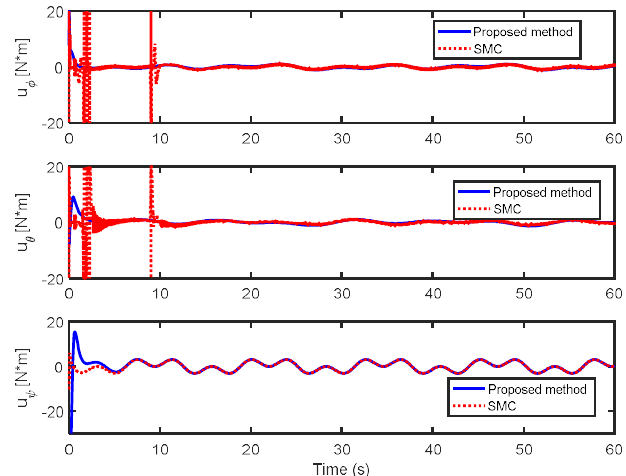
Figure 8. Comparison of control inputs between proposed method and SMC. Table 4. Contrastive outcomes between proposed method and SMC [33] in simulations.